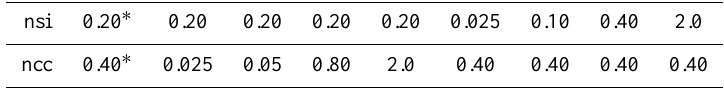
Table 2. Summary of weathering strength variations considered.